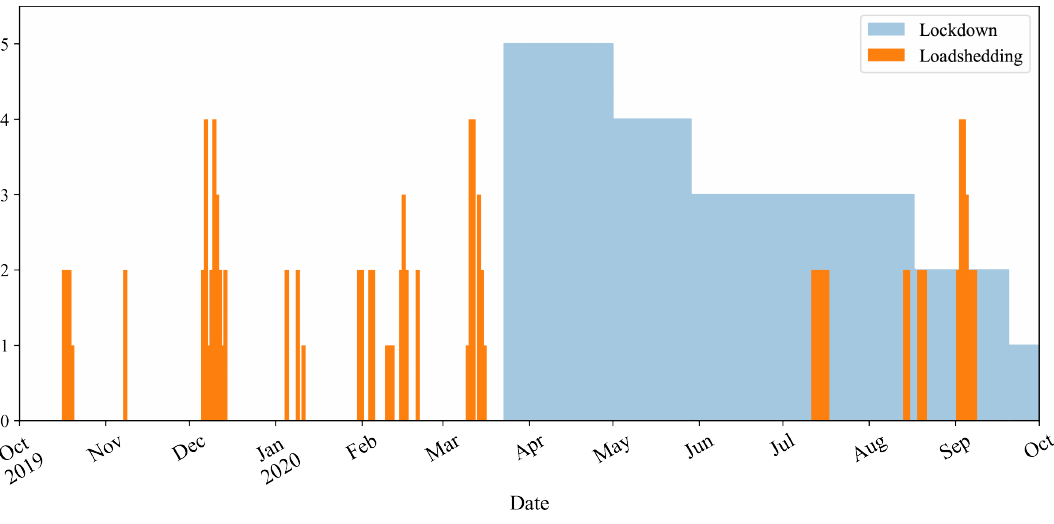
Figure 1. COVID-19 national lockdown and load-shedding timeline where the y -axis indicates the period when lockdown stage 1–5 (blue) and load-shedding stage 1–4 (orange) occurred in South